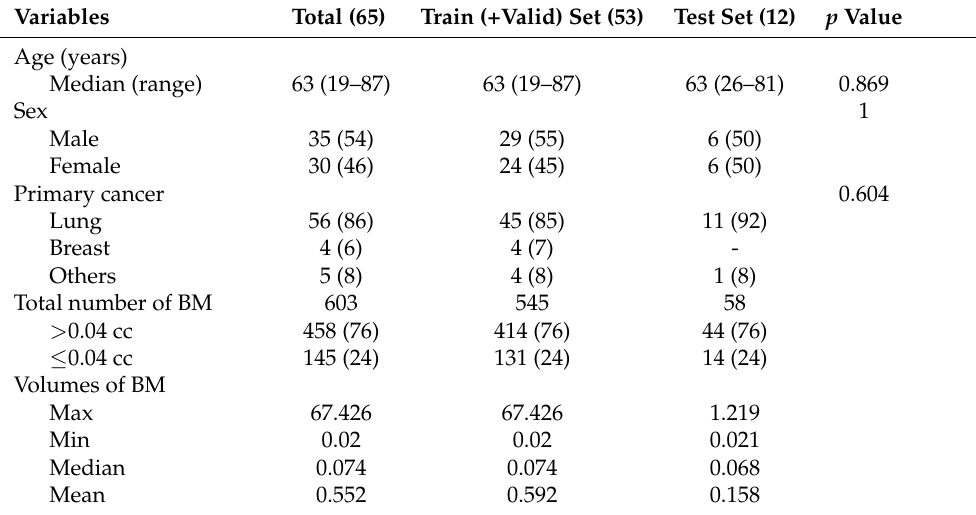
Table 1. Patient